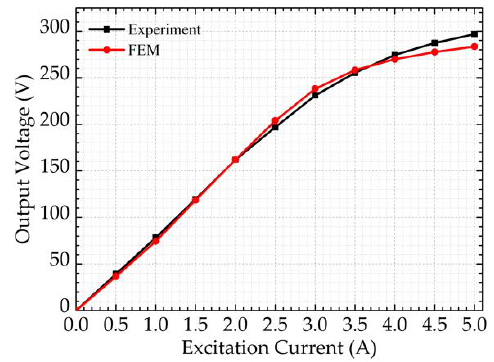
Figure 18. No-load characteristic of the BSG.